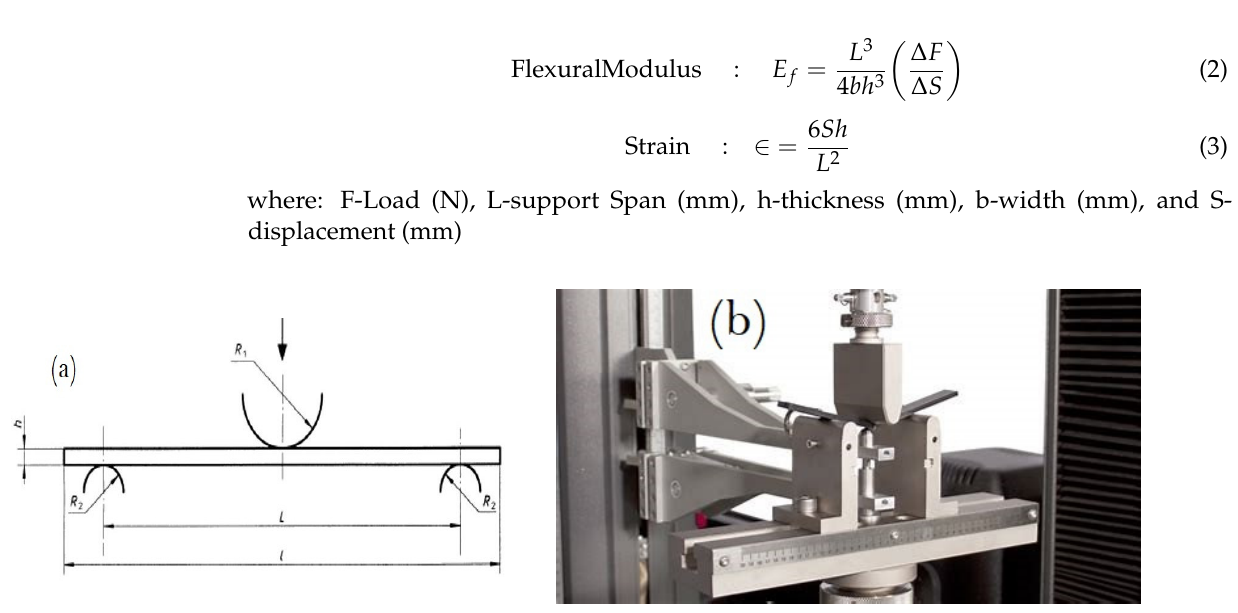
Figure 5. Flexural test set up ( a ) sketch of 3-point bend, where R1, R2, and h: 10, 5, and 2.15 mm, respectively, ( b ) Zwick Roell universal testing machine. Table 3. Test specimen